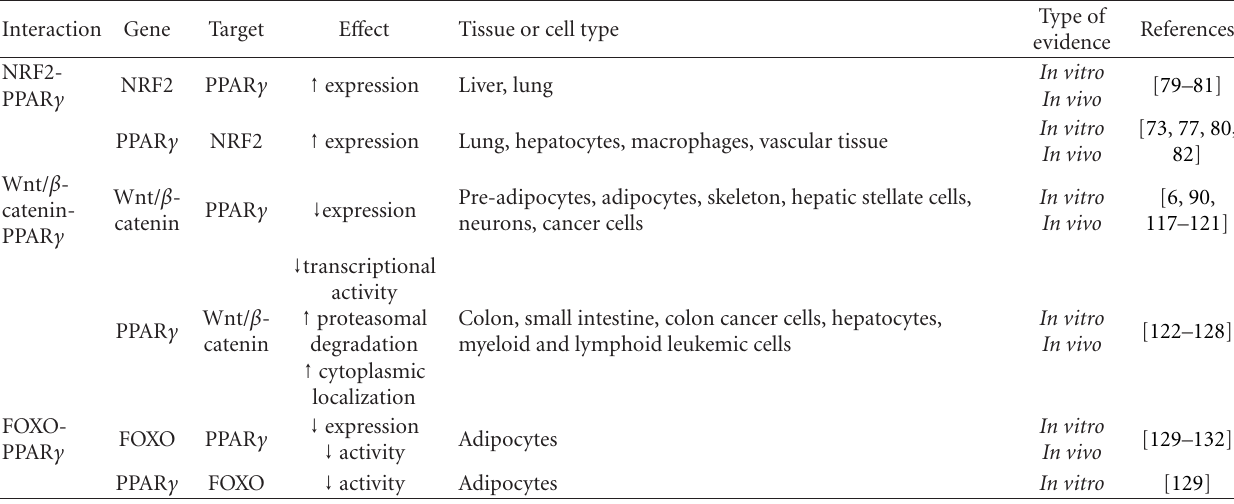
Table 2: Main experimental data linking PPAR γ to NRF2, Wnt/ β -catenin, and FOXO pathways. Interaction